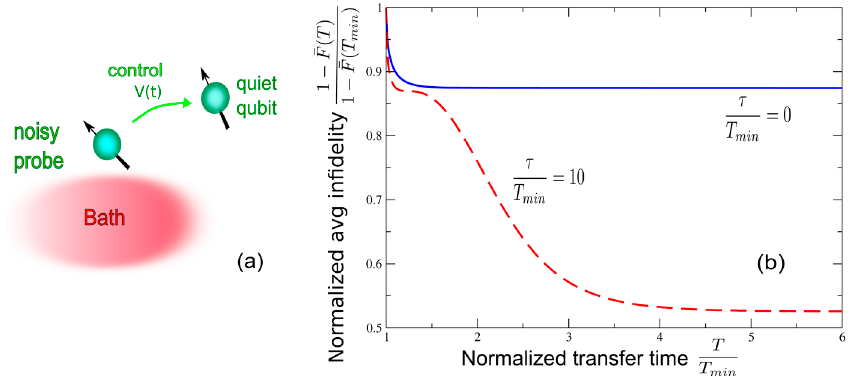
Figure 2. ( a ) Schematic view of the quantum state transfer (QST) process from a “noisy”qubit probe, due to the interaction with a bath, to the “quiet” qubit that may serve as robust storage of the information. Controlling the interaction V ( t ) allows optimized QST; ( b ) Lowest achievable averaged infidelity as a function of the transfer time T normalized to the infidelity at the fastest transfer time T min at a given transfer energy, plotted for (solid blue line) τ = 0 (Markovian) and (dashed red line) non-Markovian baths τ / T min = 10. For non-Markovian baths ( τ (cid:38) T min ) two plateaux (regions of insensitivity to T ) are found. The first plateau is independent of the memory time. The second plateau is lower for longer τ